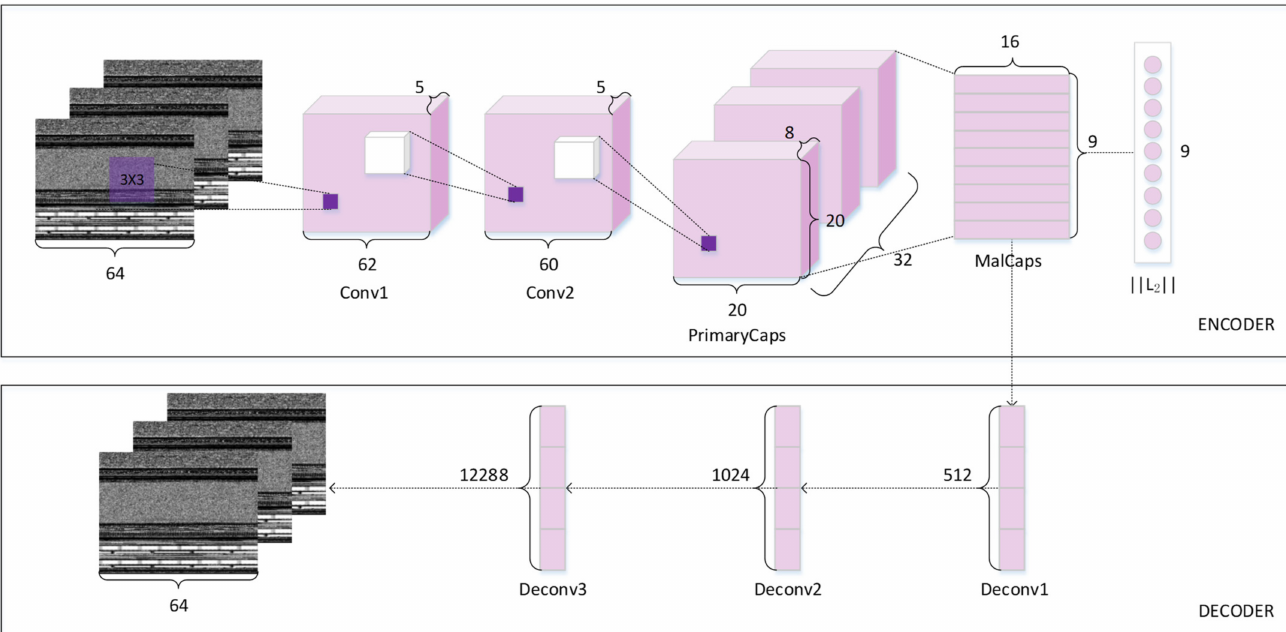
Figure 5. Architecture of the proposed